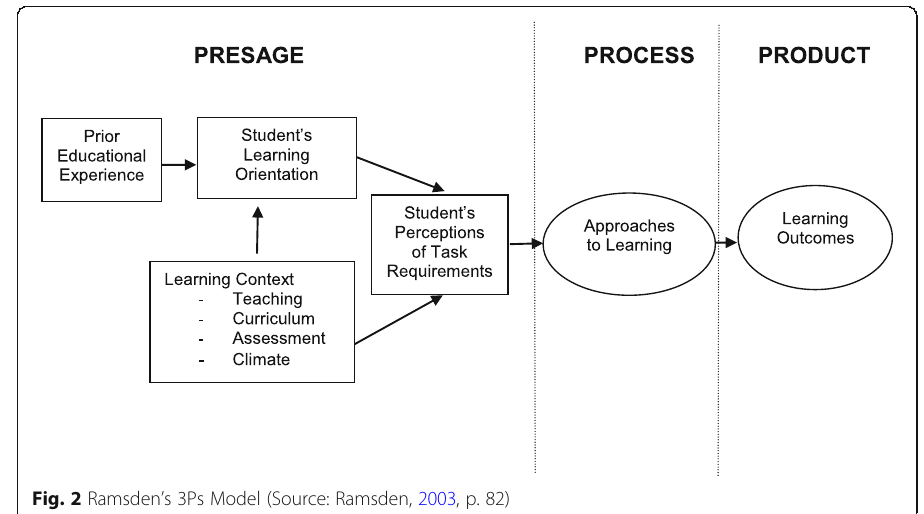
Fig. 2 Ramsden ’ s 3Ps Model (Source: Ramsden, 2003, p.